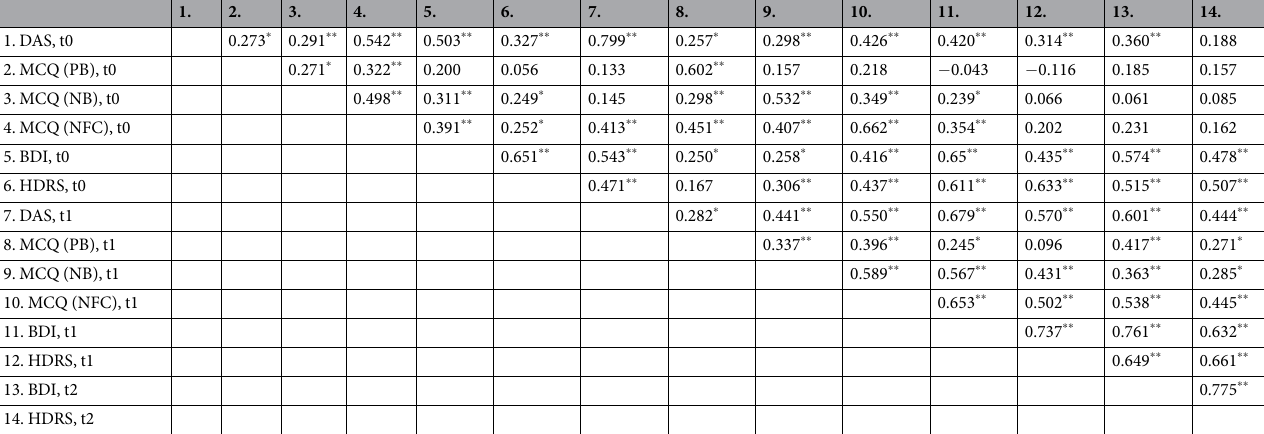
Table 3. Zero-Order Correlations Between Cognitive (DAS) Metacognitive Beliefs (MCQ) for Pre- and Post-Assessment. Note DAS = Dysfunctional Attitude Scale; MCQ (NB) = Metacognition Questionnaire, Negative Beliefs; MCQ (NFC) = Metacognition Questionnaire, Need for Control; MCQ (PB) = Metacognition